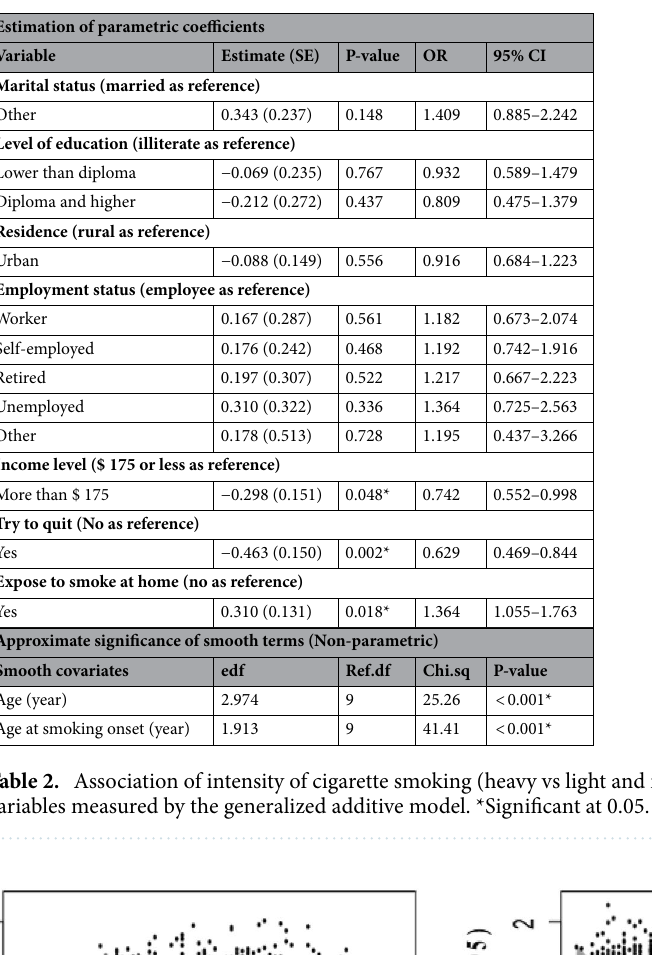
Figure 1 only shows the functional form of the relationship between the features and the outcome under consideration (smoking intensity). In order to determine the effect of the variable of age at smoking onset on the estimated probabilities of the three outcome groups, Fig. 2 is presented. Based on the results of this figure (left panel), subjects who start smoking at a younger age are more likely to become heavy smokers. Conversely, sub- jects who start smoking at an older age are more likely to become light smokers than moderate or heavy-smokers.